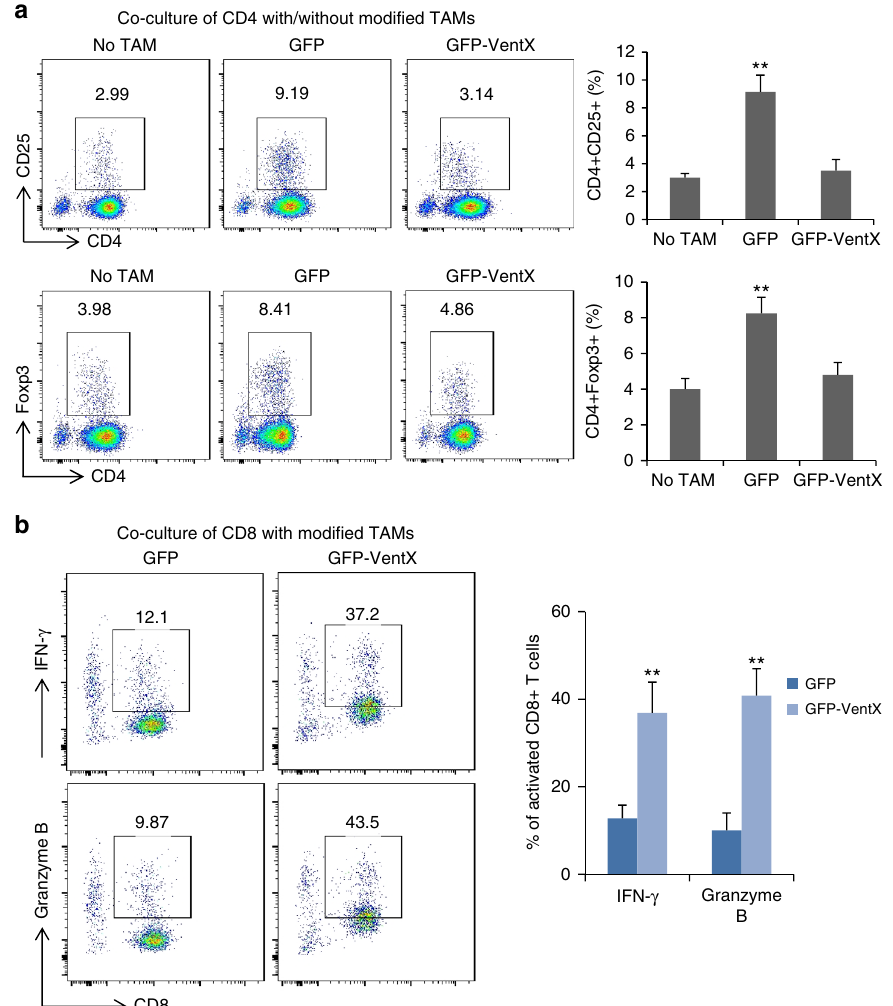
Fig. 4 VentX modulates TAM induction of TILs differentiation and activation. a VentX modulates TAM induction of T-cell differentiation. CD4 + T cells were incubated with autologus TAMs transfected with GFP or GFP-VentX for 5 days. Differentiation of the CD4 + T cells were determined by CD25 and Foxp3 analysis. The results were mean ± SD of fi ve independent experiments. b VentX modulates TAM effects on CD8 activation. CD8 TILs isolated from tumors were incubated with autologus TAMs transfected with GFP or GFP-VentX for 5 days. CD8 + TIL activation was measured by FACS analysis of IFN γ and granzyme B. Data shown are mean ± SD of three independent experiments and paired Student ’ s t -test was performed. * p < 0.05, ** p <